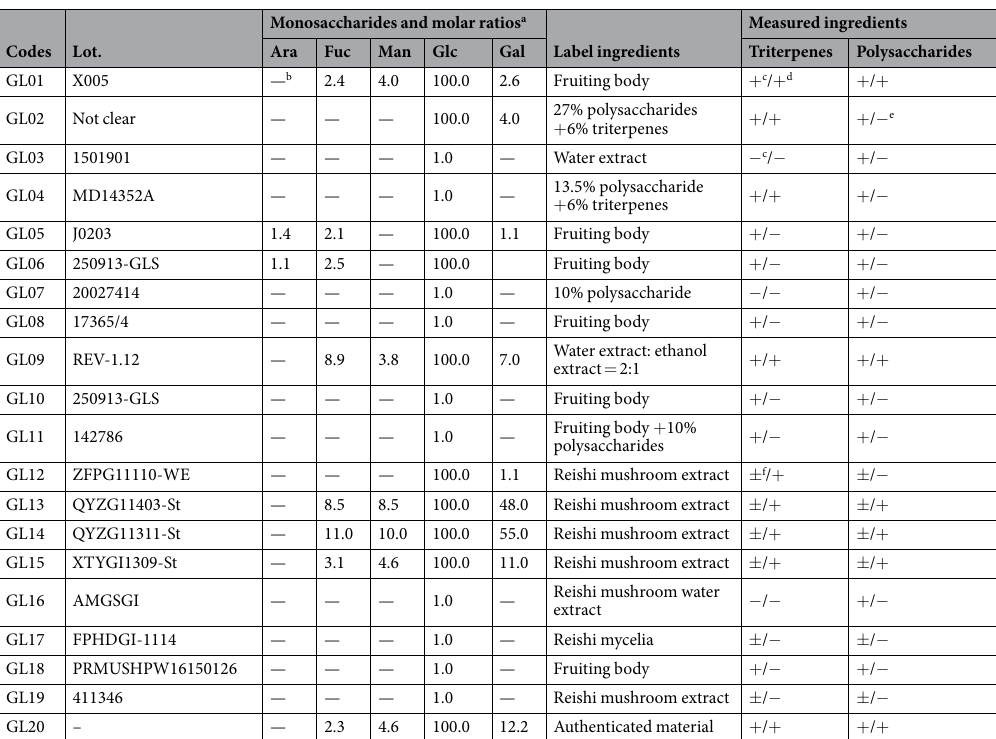
Table 1. Compositional monosaccharides of polysaccharides in G . lucidum dietary supplements and their measured ingredients. a The data was presented as average of two determinations, their relative average deviation was less than 4%; b Not detected; c labeled ( + ) or unlabeled ( + ) ingredients; d detected ( + ) or un-detected ( − ); f uncertain ( ±